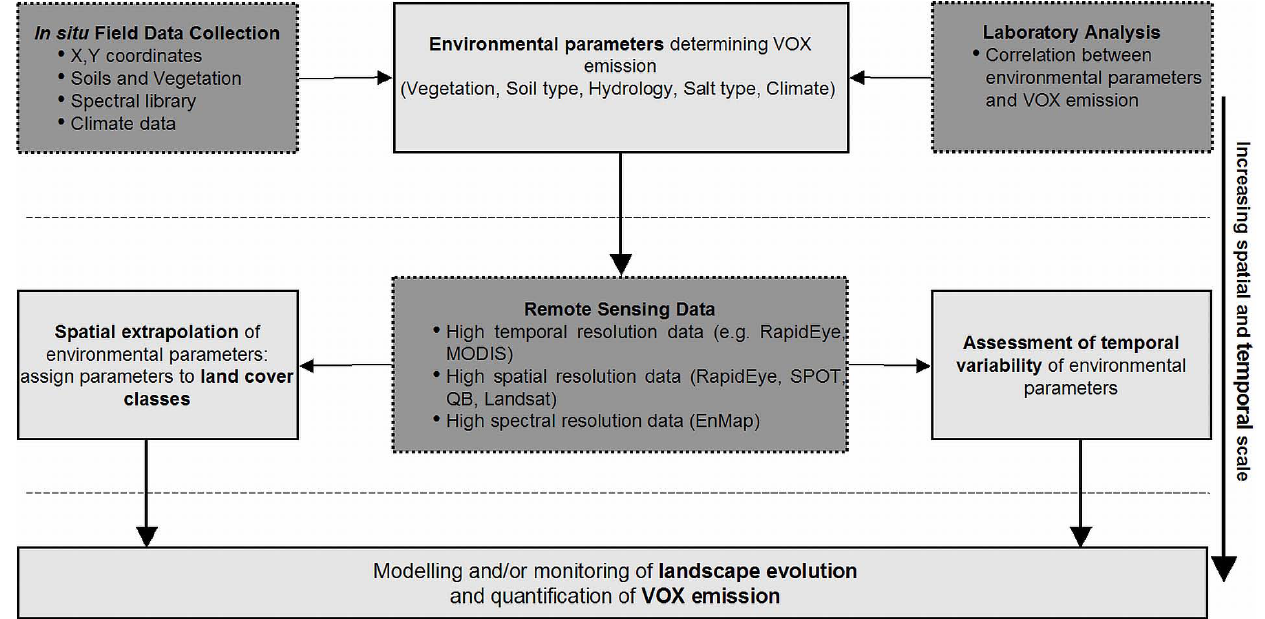
Fig. 6. Proposed flow chart for extrapolation of VOX emission from soil measurements to larger